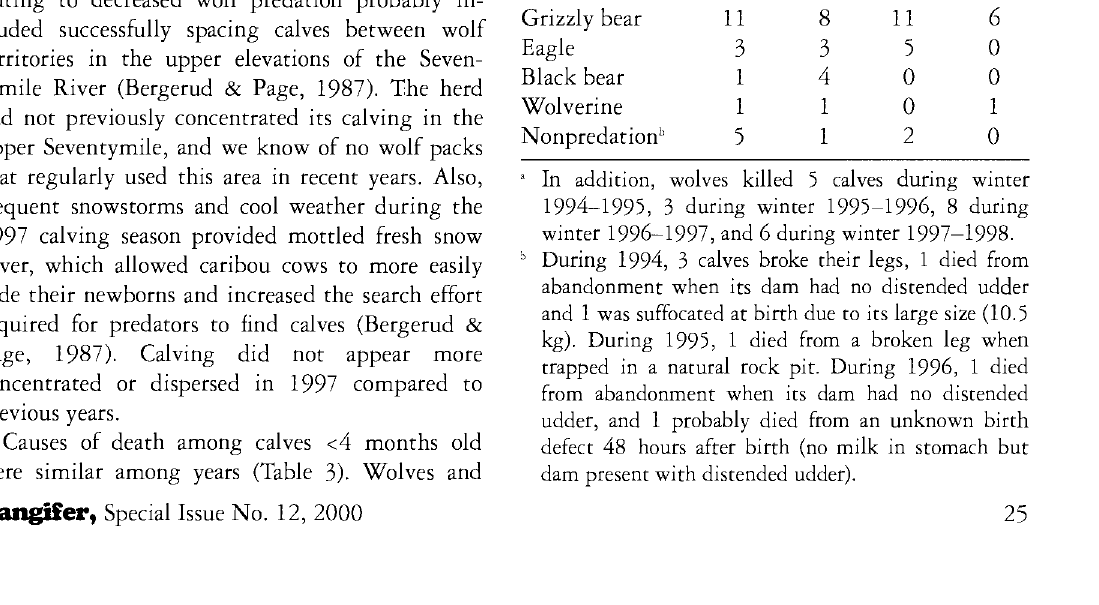
Table 3. Causes of mortality among radiocollared